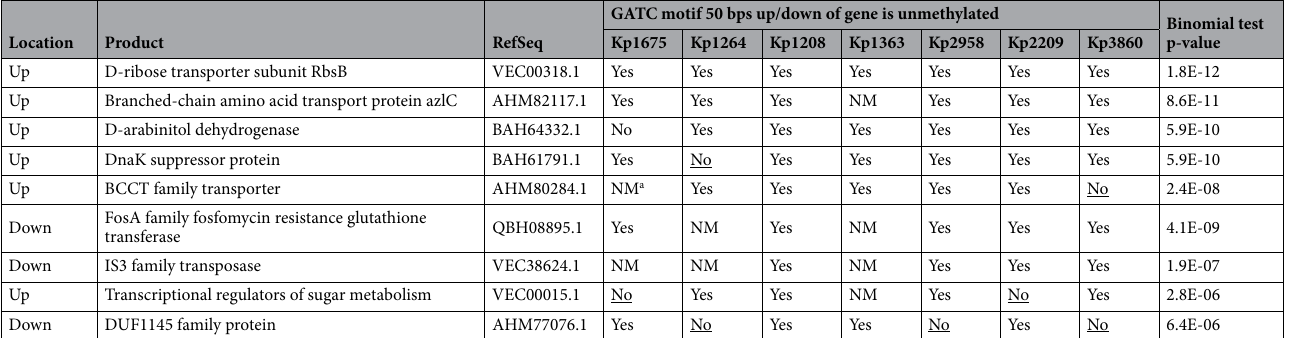
Table 3. Genes which have an unmethylated GATC motif 50bps upstream/downstream in at least four samples. Every sample has either one copy of the gene or no copies. The p-value null hypothesis is probability of gene’s GATC motif being unmethylated is the same as probability of any GATC motif being unmethylated. None of the non-GATC motifs had a p-value below 0.05. NM = no motif. a Missing start